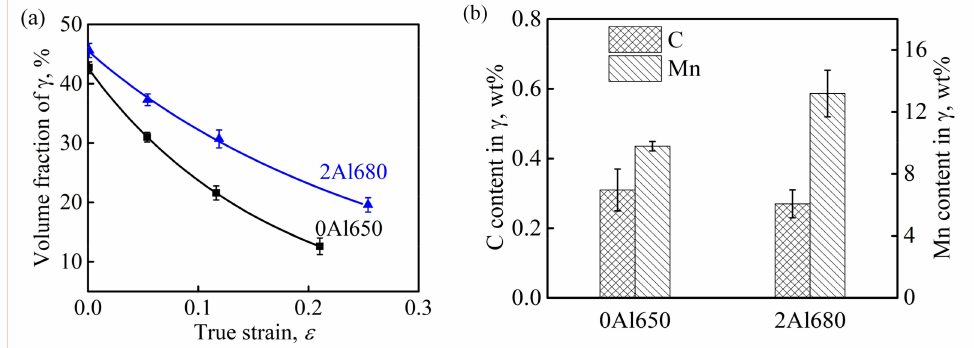
Figure 4. ( a ) Change in the volume fraction of austenite with the true strain of the 0Al650 and 2Al680 specimens. ( b ) The Mn and C concentrations in austenite (wt%) achieved by the EDS and XRD,